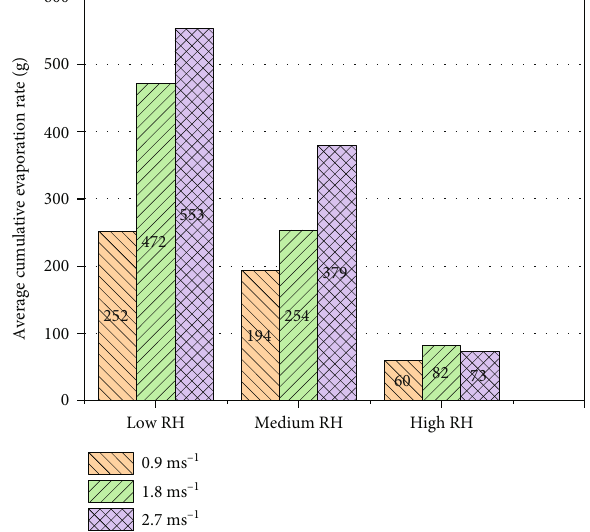
Figure 19: Average cumulative evaporation rate of the air cooler at three di ff erent velocities under three di ff erent RH